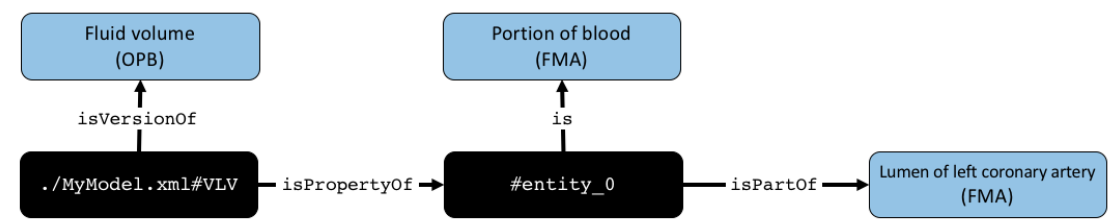
Figure 1. Node and edge representation of an example composite annotation for a model variable that simulates blood volume in the left coronary artery. RDF resources local to the OMEX metadata file are in black boxes, external knowledge resource terms are in blue